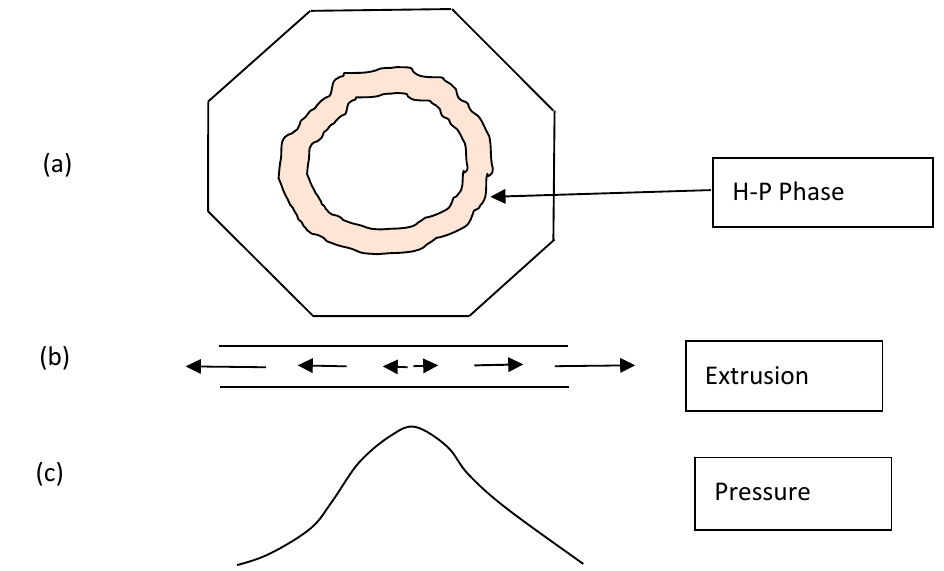
Figure 2. Olivine structure sample squeezed between diamond anvils with no gasket ( a ) View down through the upper diamond anvil. ( b ) The distribution of shear stress due to extrusion. ( c ) The distribution of pressure. In every run for every composition the spinel phase made its first appearance where the shear stress, not the pressure, was greatest. Of course, this did not give any direct information about crystal structures and the intermediate structure, but it did illustrate that all the samples with olivine structure showed the same behavior [4,5].